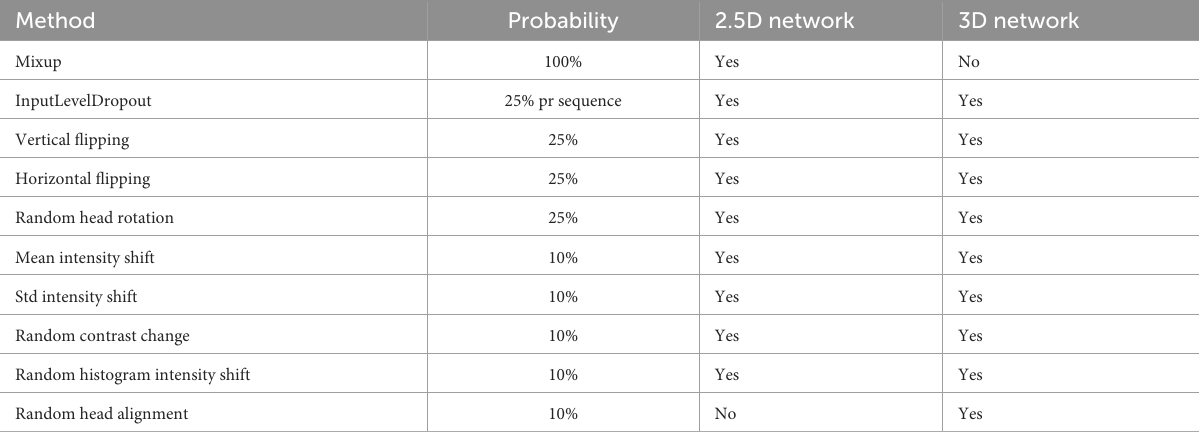
TABLE 3 An overview of the augmentation methods used, the network that used said augmentation method and the corresponding probability for their use. Method